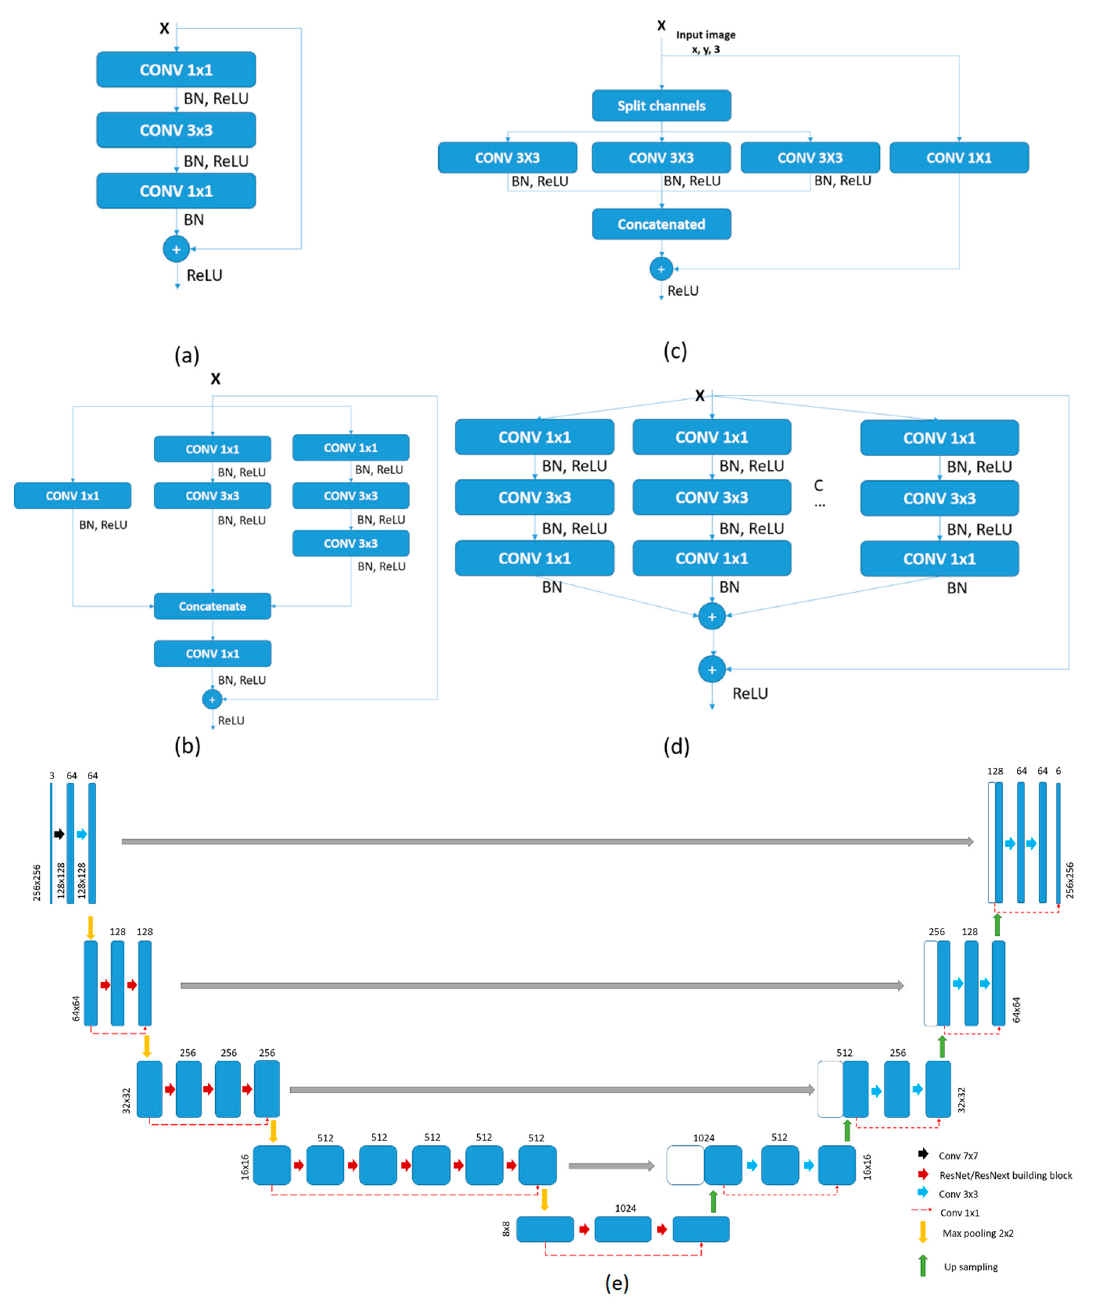
Figure 4. Building blocks of ( a ) ResNet, ( b ) Inception-ResNet v2, ( c ) Xception, and ( d ) ResNeXt (C = (C = 32) ( e ) architecture of ResUNet50 / ResUNext50. Where: ReLu is Rectified Linear Unit, BN is Batch 32) ( e ) architecture of ResUNet50/ResUNext50. Where: ReLu is Rectified Linear Unit, BN is Batch Normalization, and CONV is Normalization, and CONV is convolution.